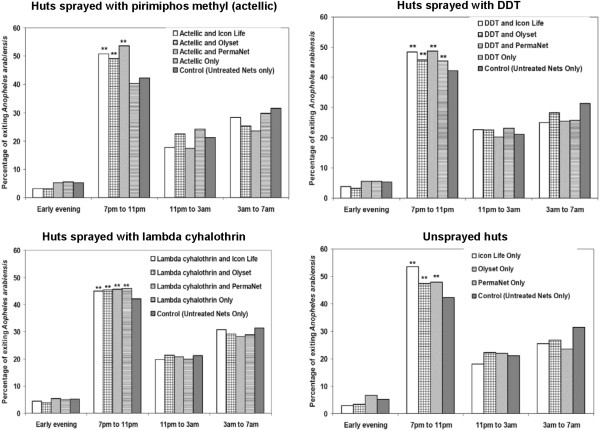
Effects of IRS/LLIN applications on the time when Anopheles arabiensis exited volunteer-occupied experimental huts during the dry season tests. Bars marked with two stars (**) denote irritant applications that caused significantly more mosquitoes (P < 0.05) to exit earlier than in the controls.